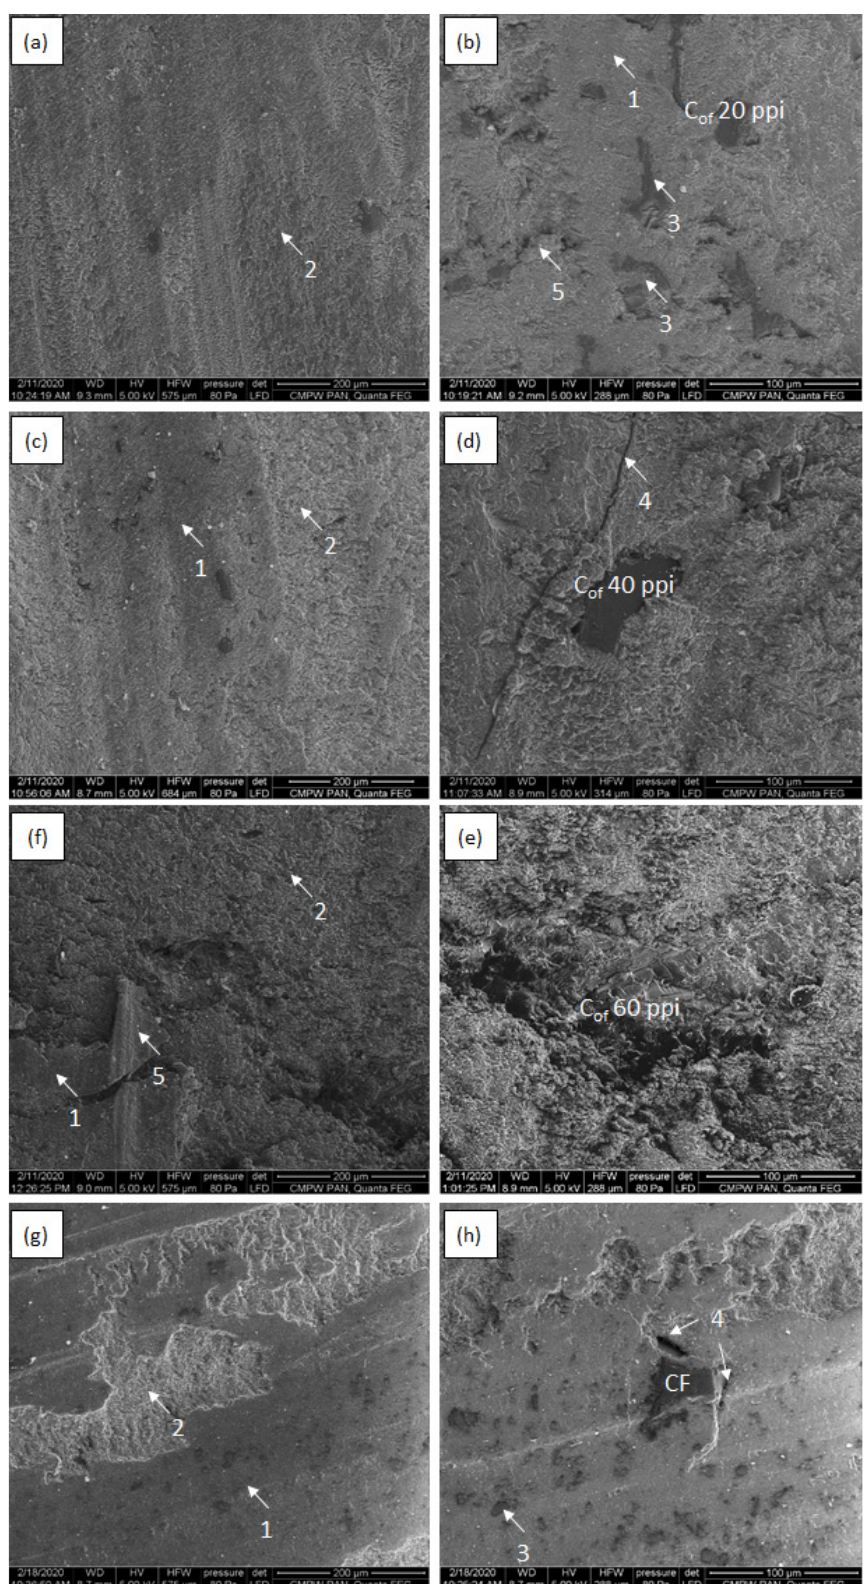
Figure 10. SEM micrographs of epoxy—C of 20 ppi ( a , b ), epoxy—C of 40 ppi ( c , d ),epoxy—C of 20 ppi ( e , f ) and epoxy–CF ( g , h ) after cooperation with cast iron counter sample under 3.5 MPa load; 1— abrasive wear of carbon foam, 2—abrasive wear and adhesive shear and transfer of matrix, 3—solid tribofilm, 4—cracks at interface, 5—matrix delamination.